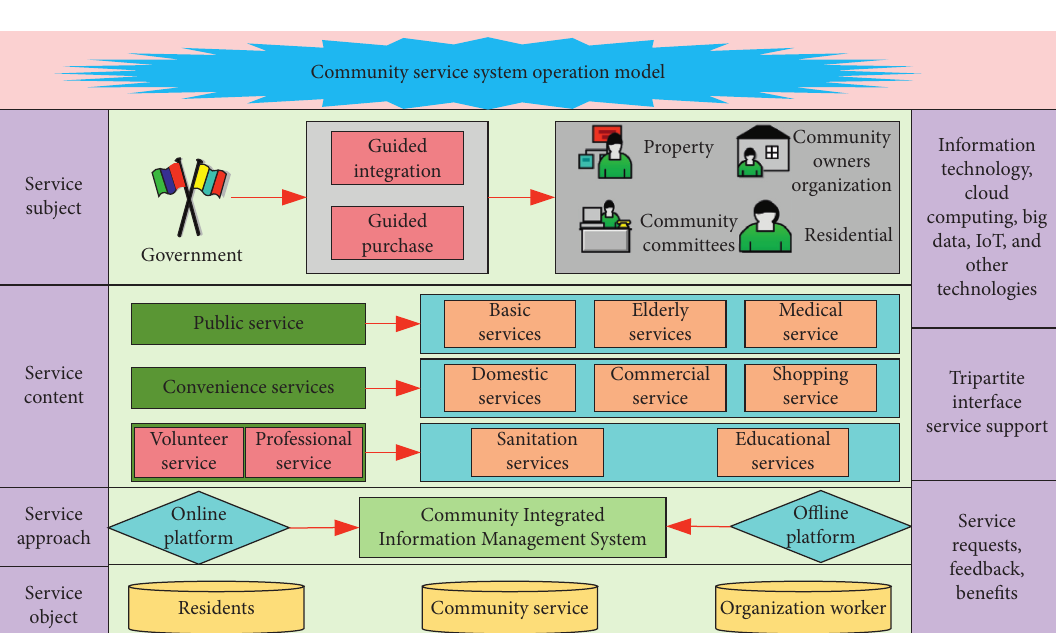
Figure 2: The composition of community service system and its operation